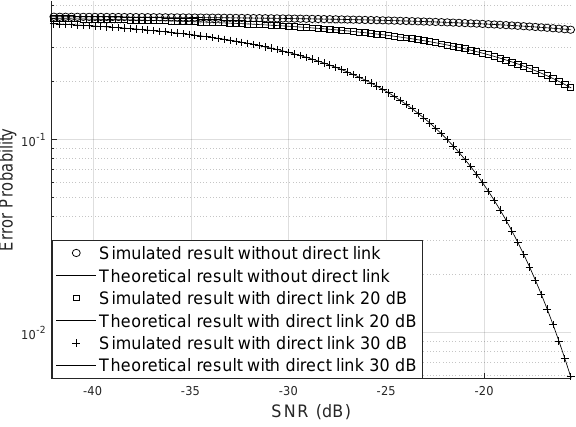
Figure 11. Effect of the direct link in the bit error